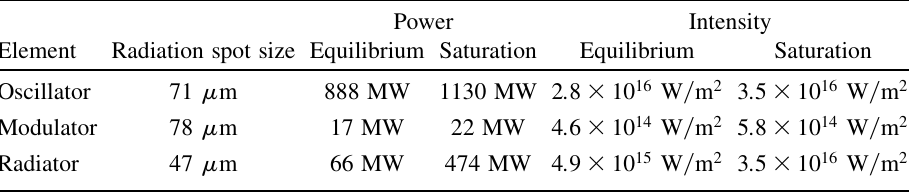
TABLE IV. Performance of the radiator-first beam line in equilibrium, and compared to nominal saturation